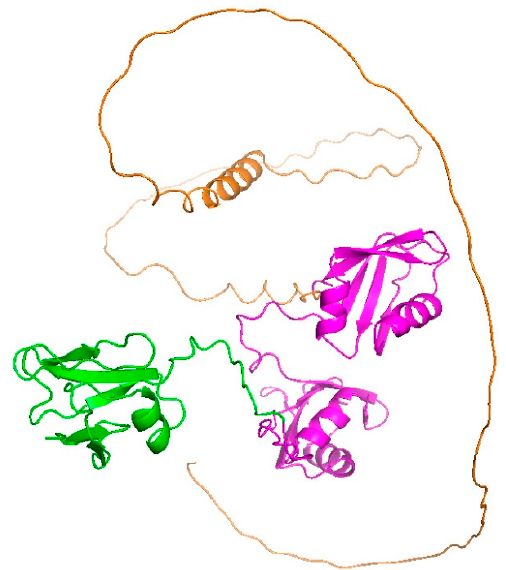
Figure 1. Domain structure of TDP-43 predicted by AlphaFold2 (Q13148). An N-terminal ubiquitin- like dimerization domain (NTD) (green), two RNA/DNA-recognition motifs (RRM 1 and 2) (ma- genta), and a C-terminal intrinsically disordered region (IDR), including a prion-like Q/N-rich do- main (orange).